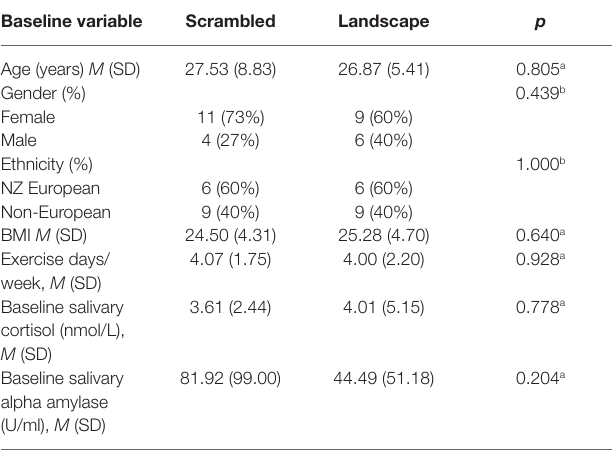
TABLE 1 | Summary of demographic and baseline characteristics of participants across